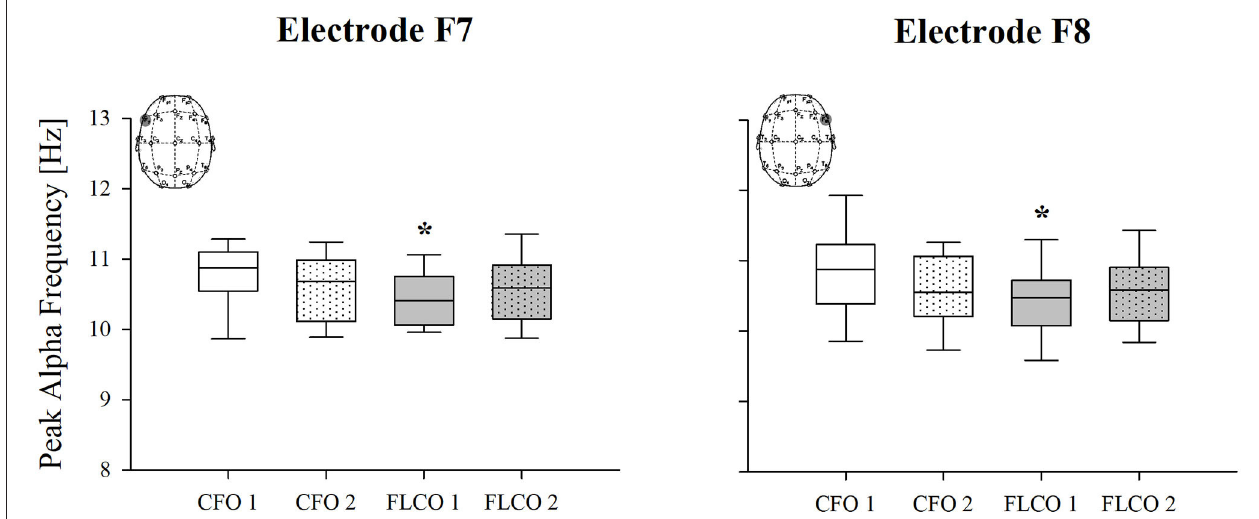
FIGURE 2 | A box-and-whisker plot representing the median (line within the box), the interquartile range (length of the box), the 90th and 10th percentiles (whiskers above and below the box) of the electroencephalographic derived peak alpha frequency (PAF) in F7 (left panel) and F8 electrodes (right panel) in operators who worked in COVID-19-free wards and departments (CFO, white) and in frontline COVID-19 operators during the pandemic (FLCO, gray) during the first (1) and the second sessions (2). * p < 0.05 CFO1 vs. FLCO1.